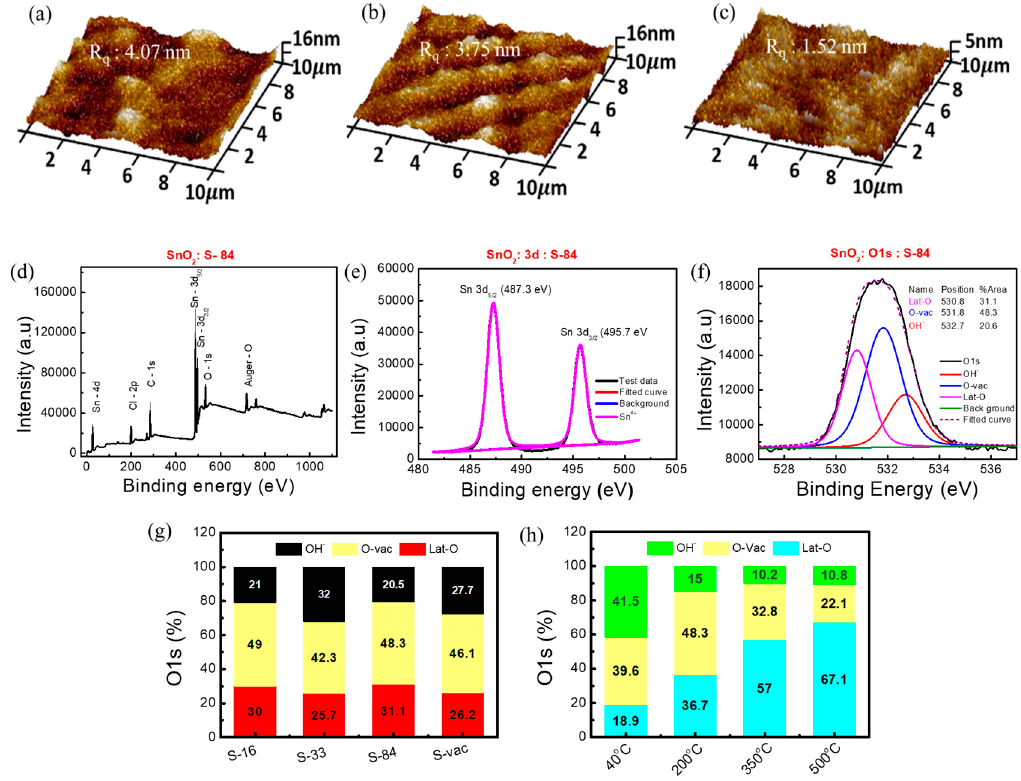
Figure 3. AFM images of ( a ) S − 16 , ( b ) S − 33, and ( c ) S − 84 . XPS spectra of ( d ) SnO 2 film grown on HDPE/resin plastic wrap, ( e ) Sn 3d, ( f ) O1s with three components, Lat-O, O-vac, and OH - . Analysis O1s data of ( g ) SnO 2 on HDPE/resin substrate and ( h ) SnO 2 on glass substrate. O1s data of ( g ) SnO 2 on HDPE/resin substrate and ( h ) SnO 2 on glass